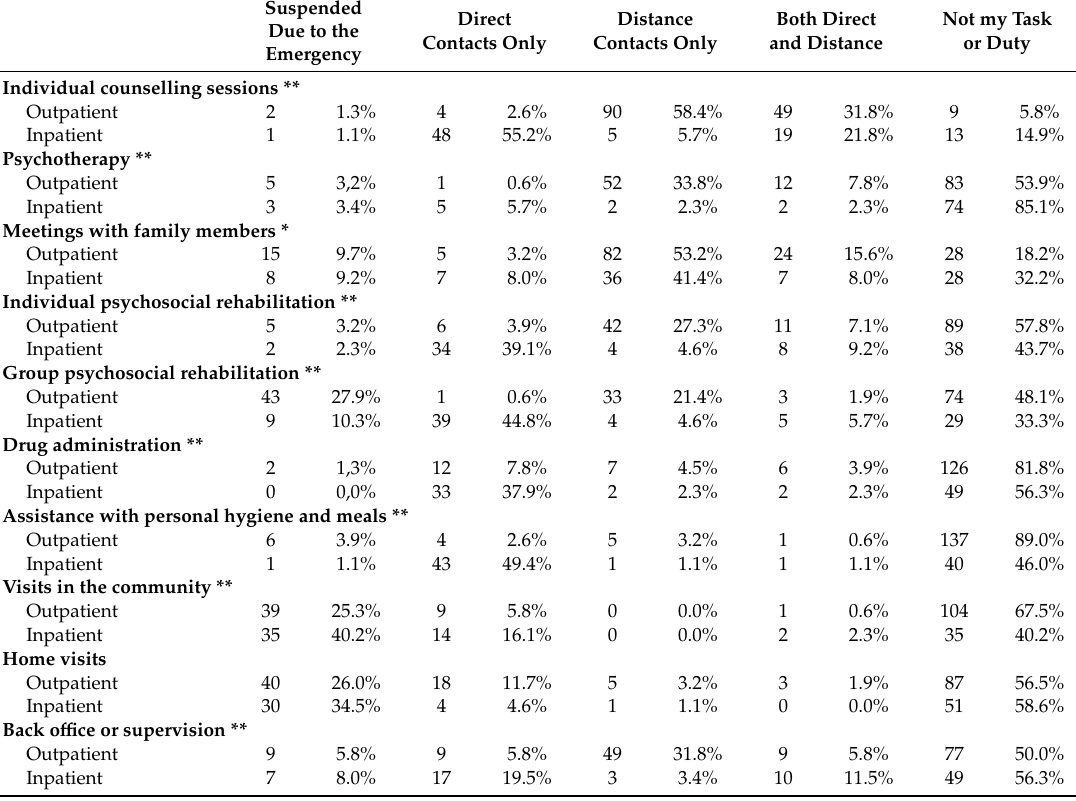
Table 5. Interventions performed by mental health workers in outpatient and inpatient services during the early stage of Covid-19 outbreak.